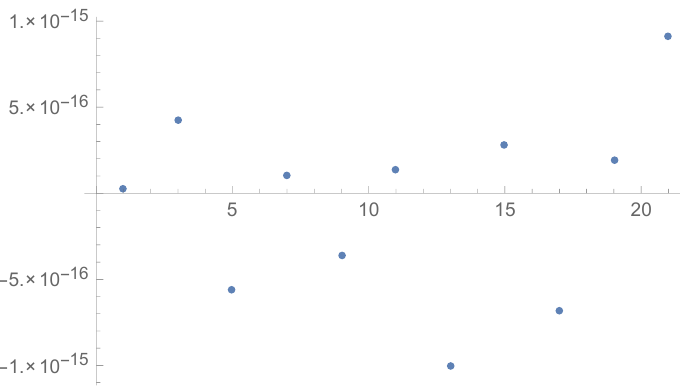
Figure 6. Differences (in N) between the measured Fourier coefficients b m from Figure 5 and the best fit curve b m